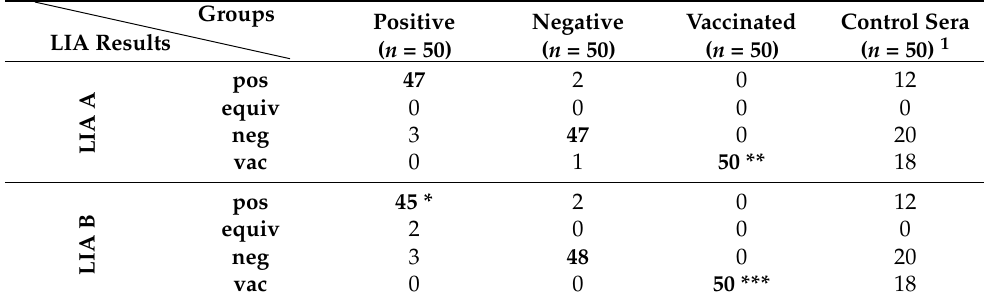
Table 6. Defined Bb sl-serostatus of dogs (Groups; n = 200) and allocated results after the second round of serologic testing using LIA A and LIA